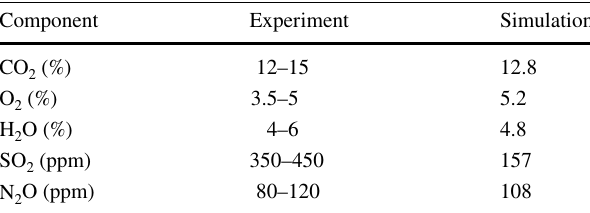
Table 6 Validation of the model based on flue gas composition for Ekibastuz coal combustion